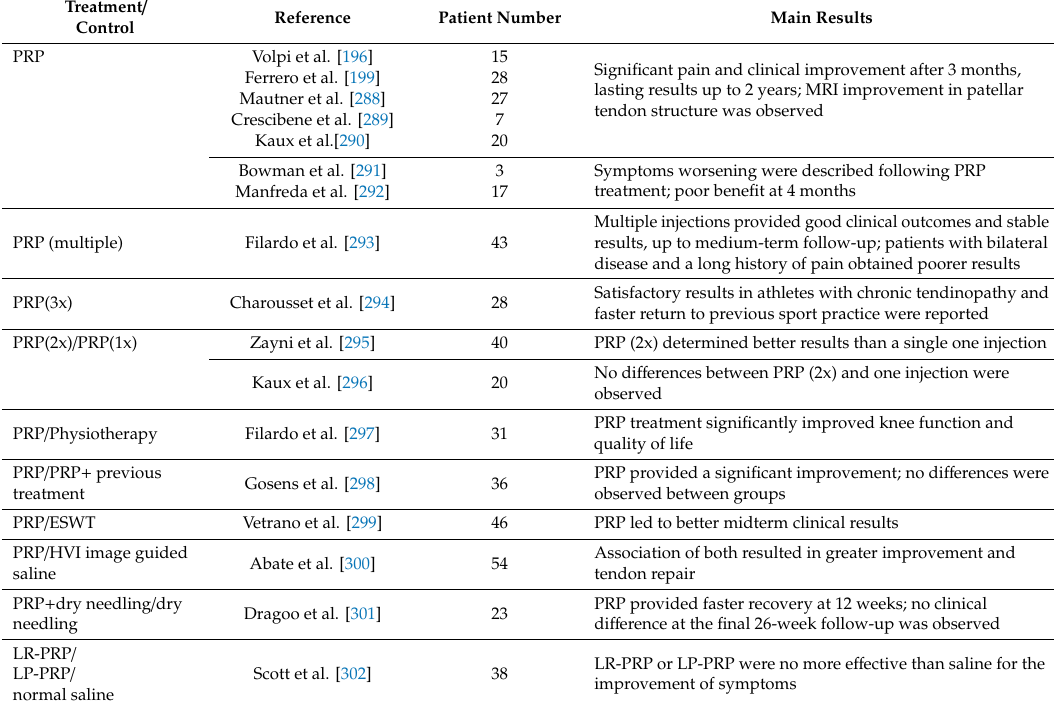
Table 8. Evidence of PRP treatment in patellar tendinopathy (reported by year of study and treatment